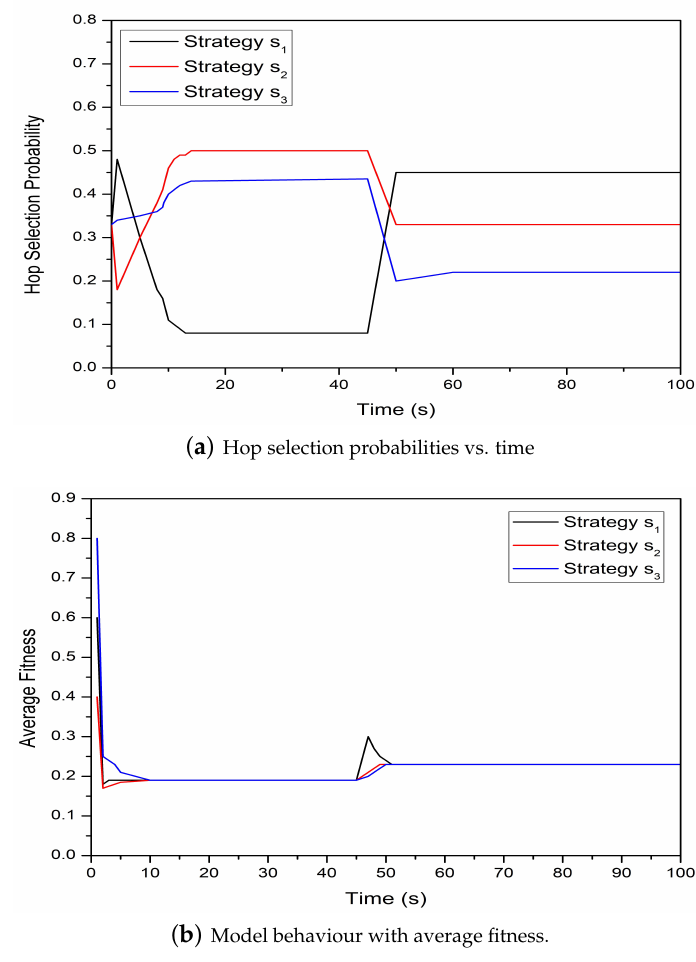
Figure 7. The comparison of average fitness and hop selection probability with time for the proposed